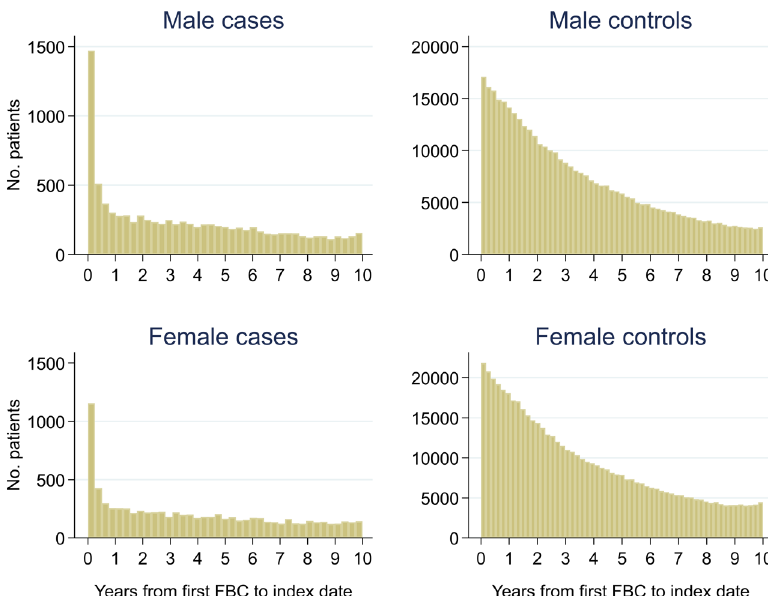
Figure 2. Histogram of follow-up time from first FBC to index date 1,2 . 1 Index date was the date of diagnosis for cases and a randomly selected date in the patient’s study period for controls. 2 The spike at time=0 in cases is likely due to patients undergoing cancer investigation. This was not expected to influence trends, as the trends rely on sufficient data at each time-point, not comparability of